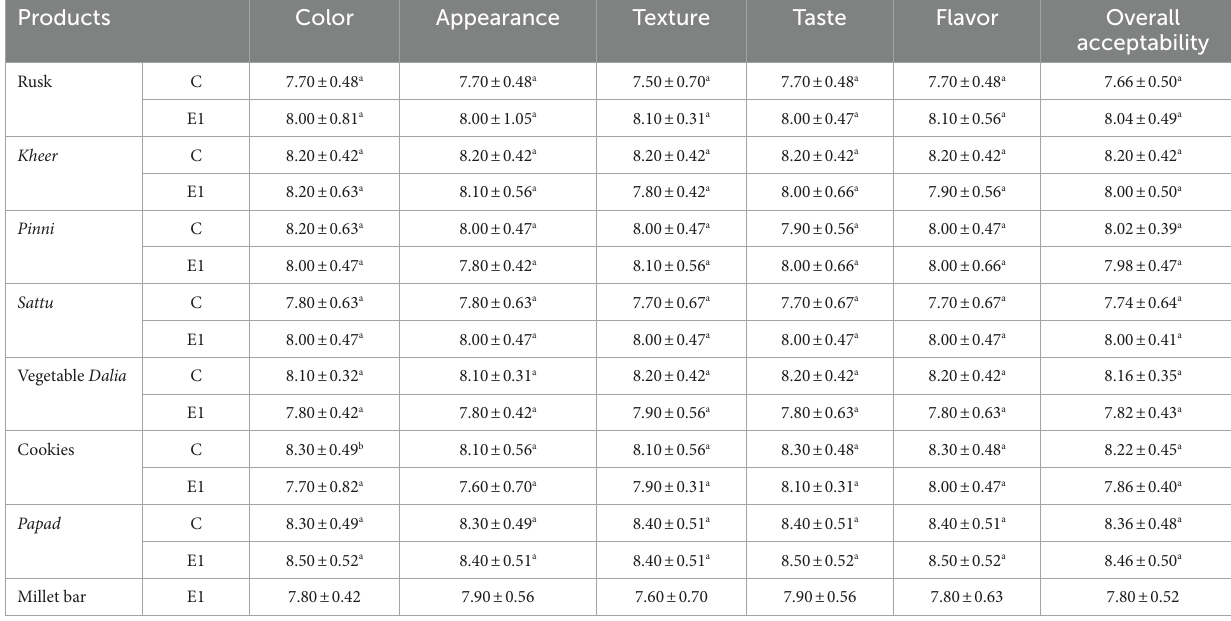
TABLE 3 Organoleptic evaluation of the products prepared from Foxtail millet. Products